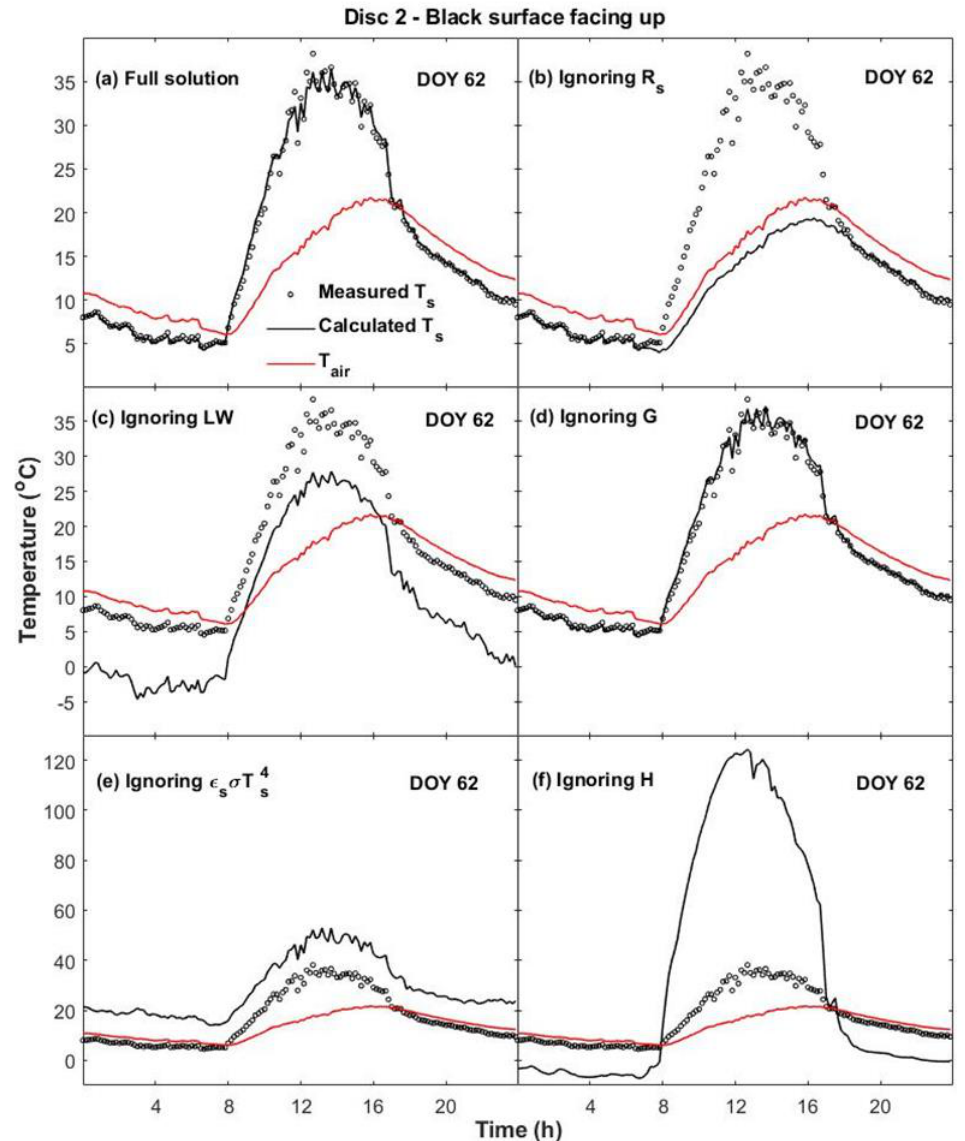
Figure 10. Calculated and measured temperature of the upper surface ( black ) of disc 2 on day of year (DOY) 62. Complete solution of the energy balance equation is shown in ( a ). Calculations are intended to show the errors in temperature estimation by neglecting: ( b ) solar irradiance (R s ), ( c ) longwave sky radiation (LW), ( d ) sensible heat flux by conduction (G), ( e ) emitted thermal radiation ( ε s σ T s4 ), and ( f ) sensible heat flux by convection (H).